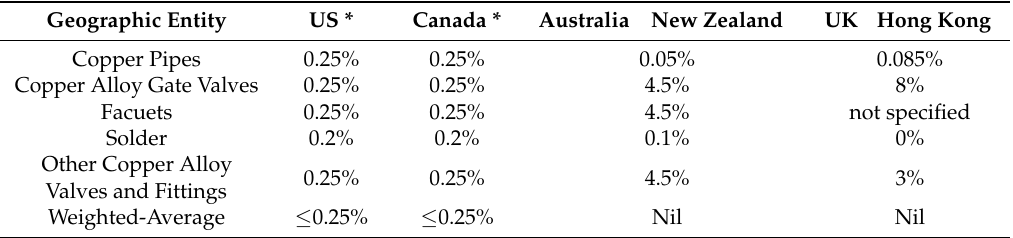
Table 2. Comparison of maximum allowable lead content (by % of weight) in copper pipe and copper alloy valves and fittings in various geographic